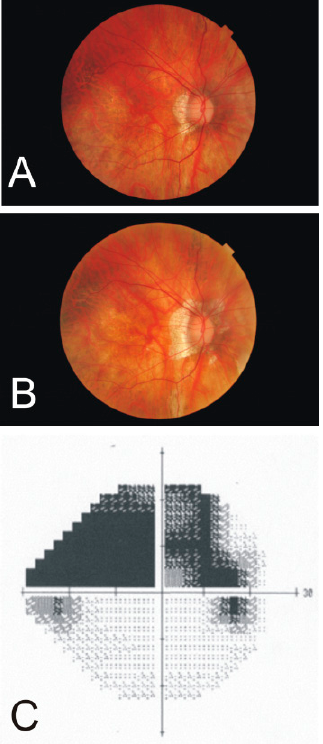
Figure 4. Fundus photographs of the right eye of a female with high myopia at age 45 ( A ) and